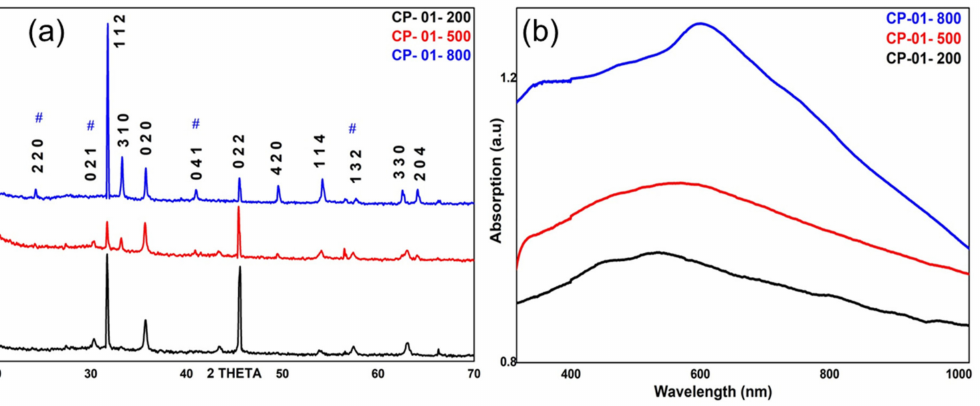
Figure 2. ( a ) XRD and ( b ) UV–visible absorption measurements of titanium ferrite nanopowder cal- cined at different temperatures. XRD peaks marked with # are assigned to the orthorhombic system.